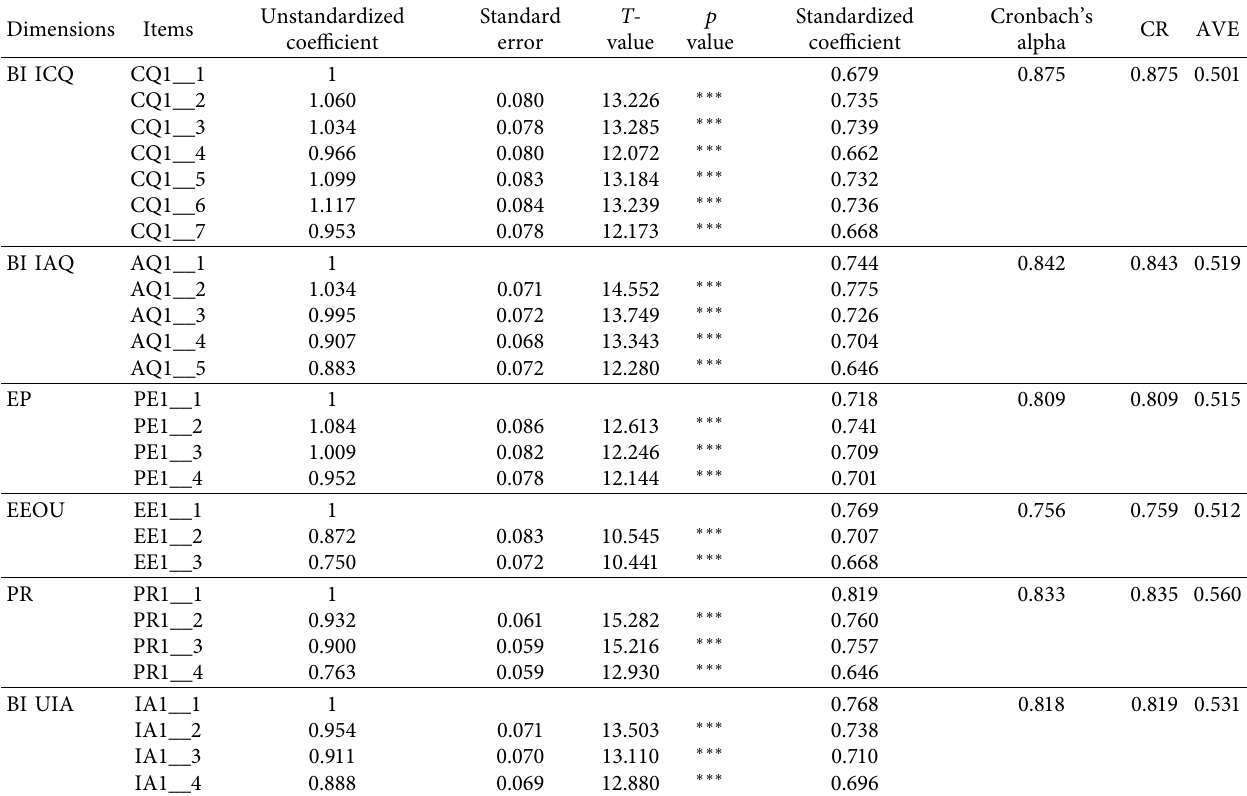
Table 5: AVE, CR, and Cronbach’s alpha values of measurement variables.